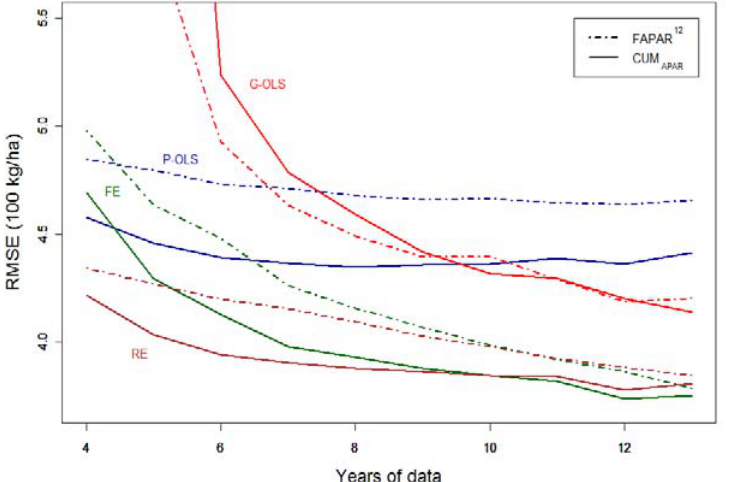
Figure 6. Jackknifed Root Mean Square Error (RMSE) of different modeling solutions as a function of the number of available years of data (the parameters of each model have been estimated with the years available less one). Only models using FAPAR 12 and CUM are